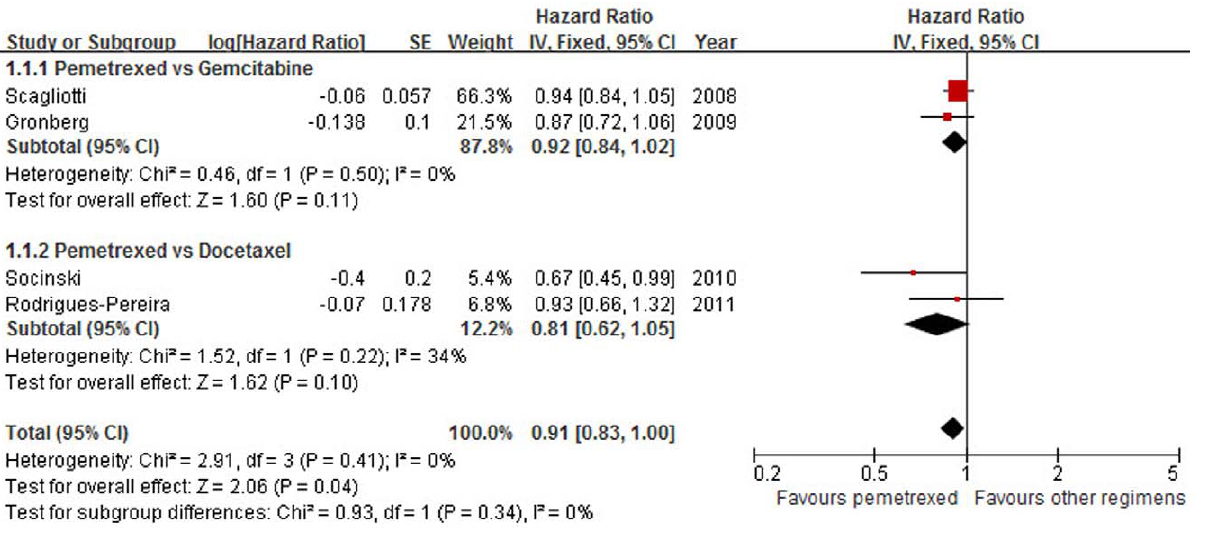
Figure 2. Comparison of overall survival between pemetrexed plus platinum chemotherapy and other platinum-based regimens. Abbreviations: SE, standard error; IV, inverse variance; CI, confidence interval.